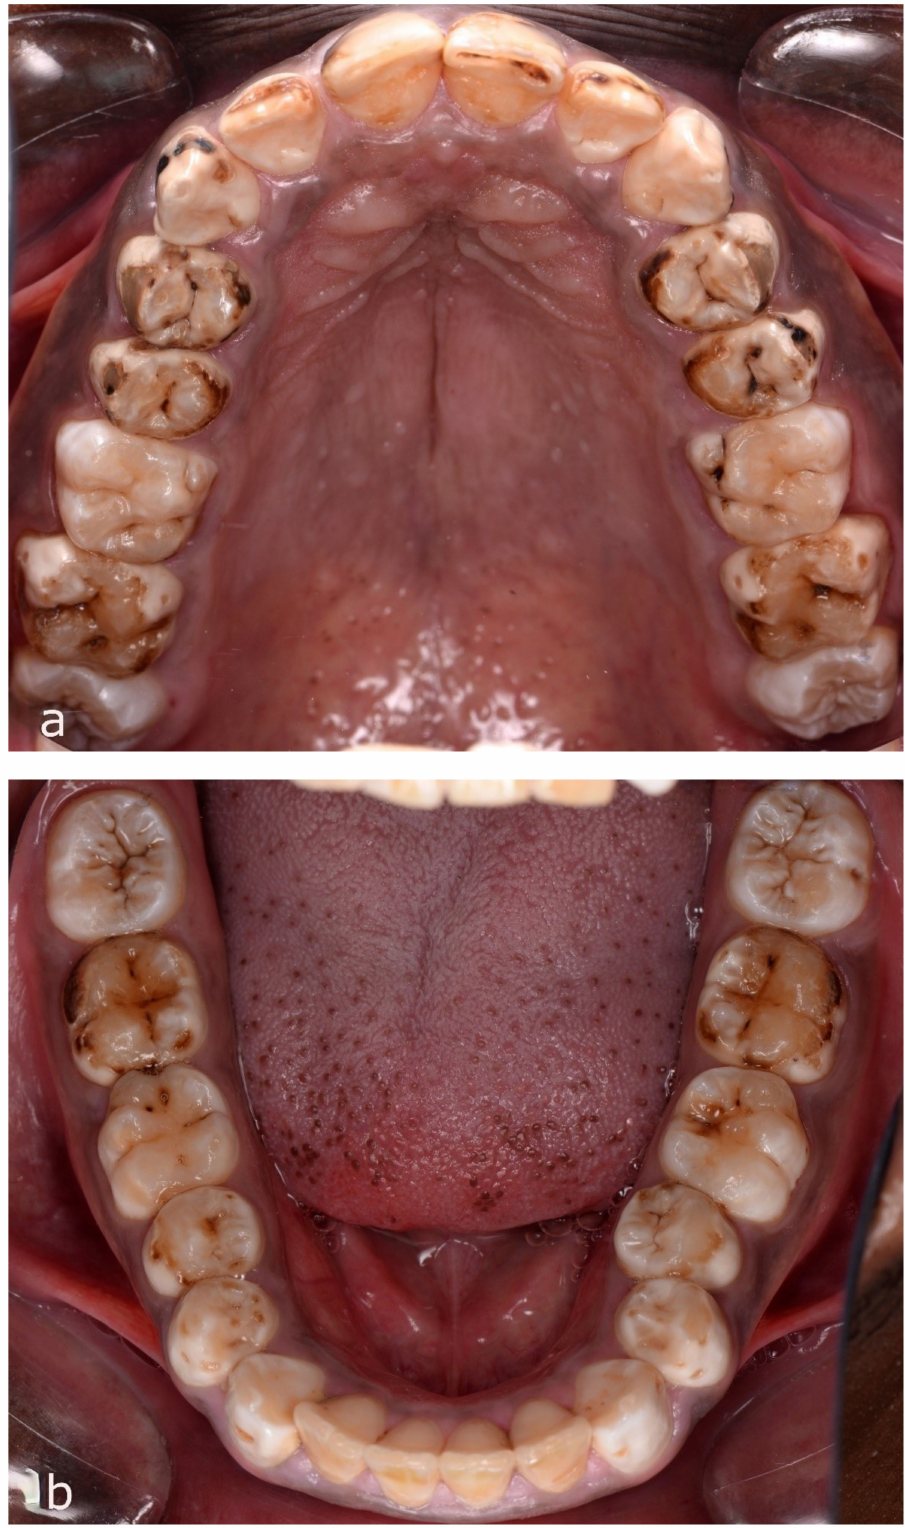
Figure 3. Occlusal views of pretreatment: ( a ) maxillary occlusal view and ( b ) mandibular occlusal